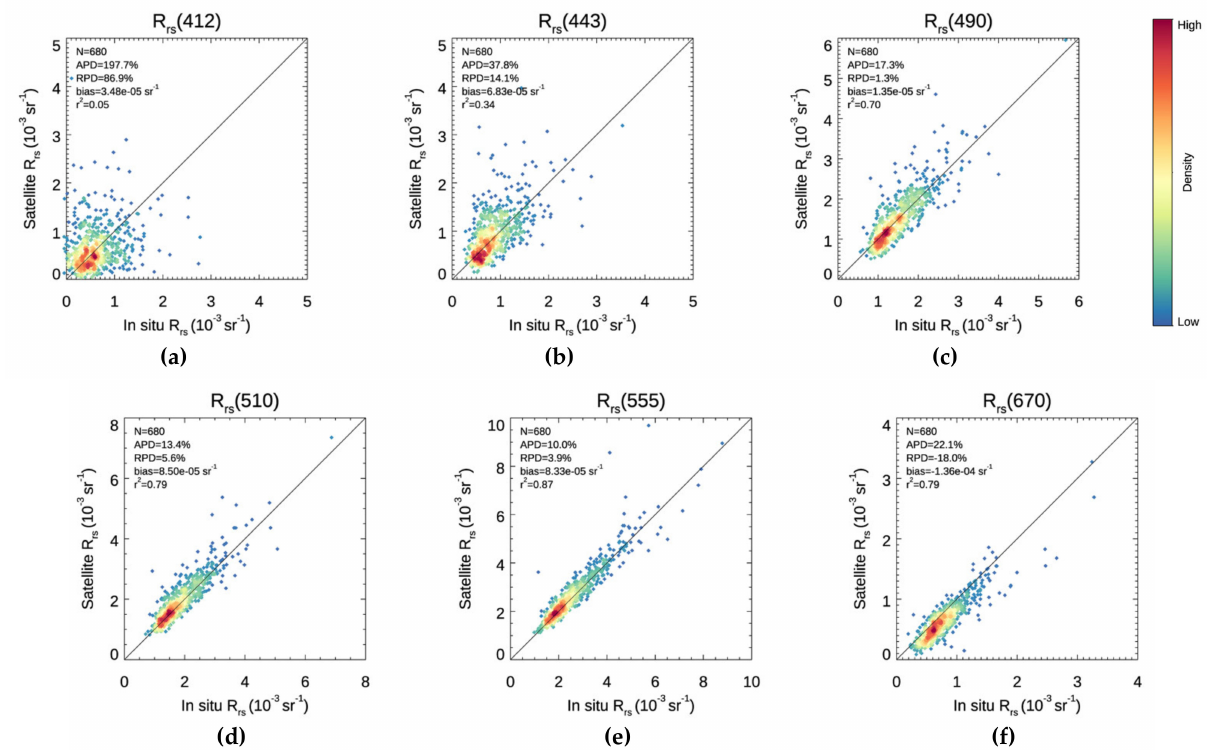
Figure 3. Scatterplots of R rs match-ups: space-borne versus in situ measurements. Data points are color-coded by density. The continuous line represents the 1:1 ratio. ( a – f ) R rs ( 412 ) to R rs ( 670 )